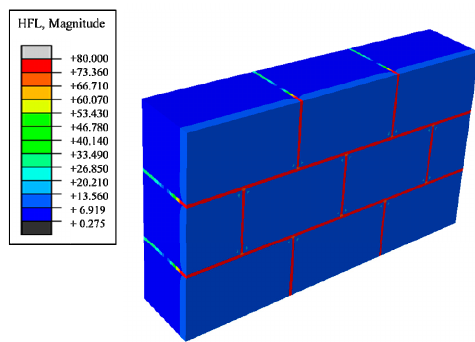
Figure 13. Transient heat transfer heat flux peak nephogram.